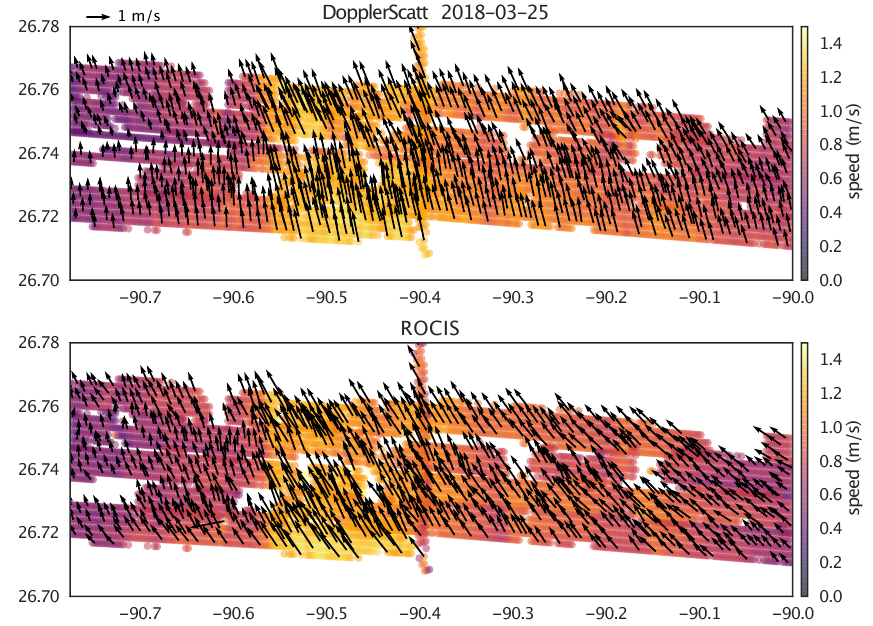
Figure 20. ( upper ) DopplerScatt surface current speed (color) and direction interpolated to ROCIS locations; ( lower ) ROCIS data. Data collected on March25,